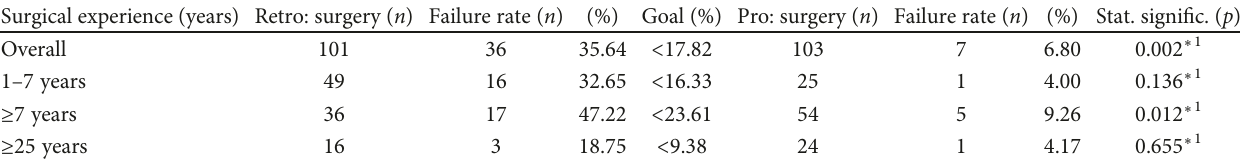
Table 2: Failure rate depending on surgical